Question: Write a descriptive caption for this figure.
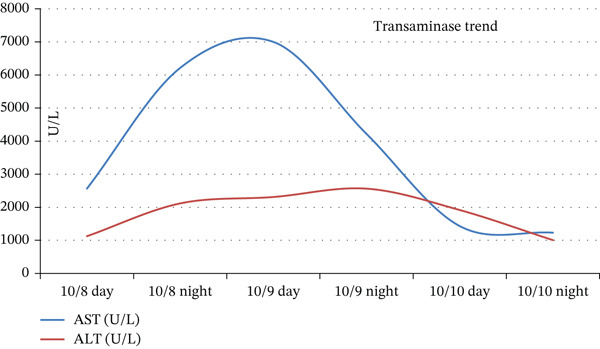
Answer: Trend of serum transaminases during the ICU course.